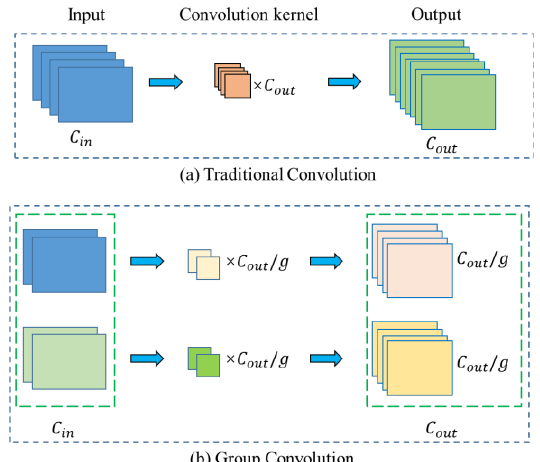
Figure 4. Grouped Convolution. C in , C out , and g denote the number of input feature maps, the number of output feature maps, and the number of groups, respectively. g = 2 in the example.